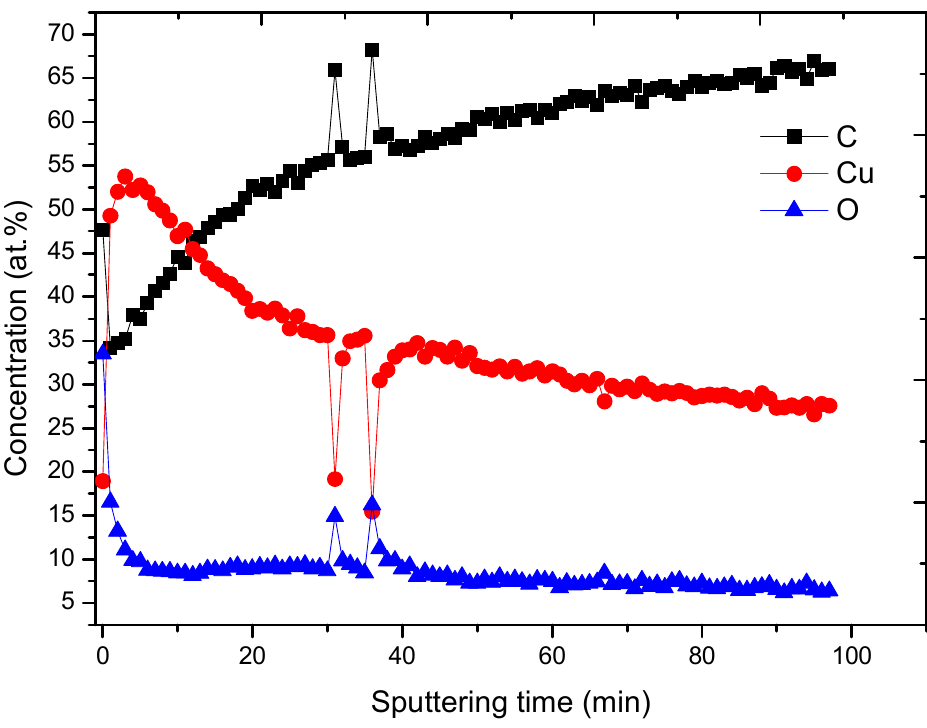
Figure 5. XPS depth profiling results for PCL-Cu sample.